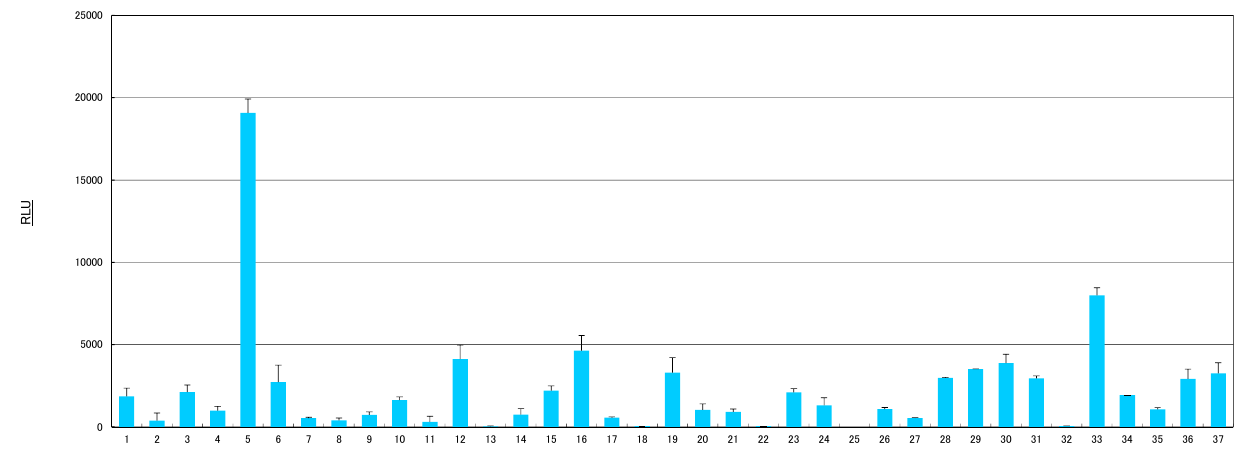
Figure 1. Induction of luciferase activity by health food materials in the CALUX assay. The numbers on the x-axis describe the components listed in Table 1. Sample extracts were used at a final concentration of 100 μ g/mL. Results are expressed as means ± SDs.